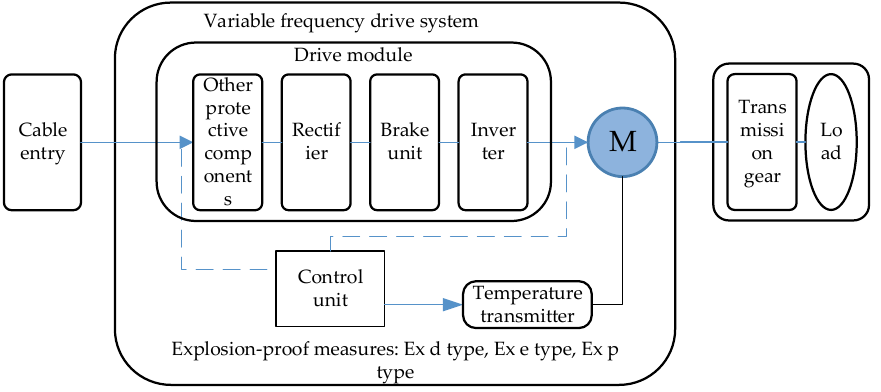
Figure 5. Block diagram of VFD system for explosive environment.